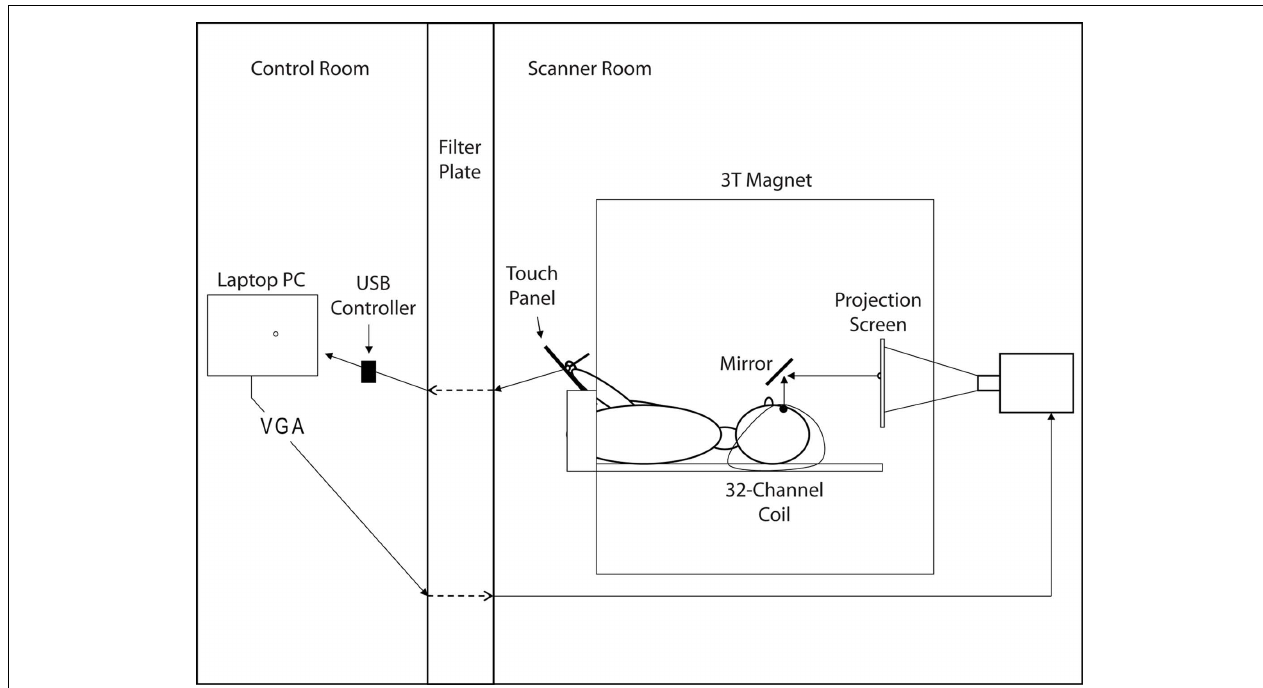
FIGURE 2 | Illustration of the experimental set-up. For details see